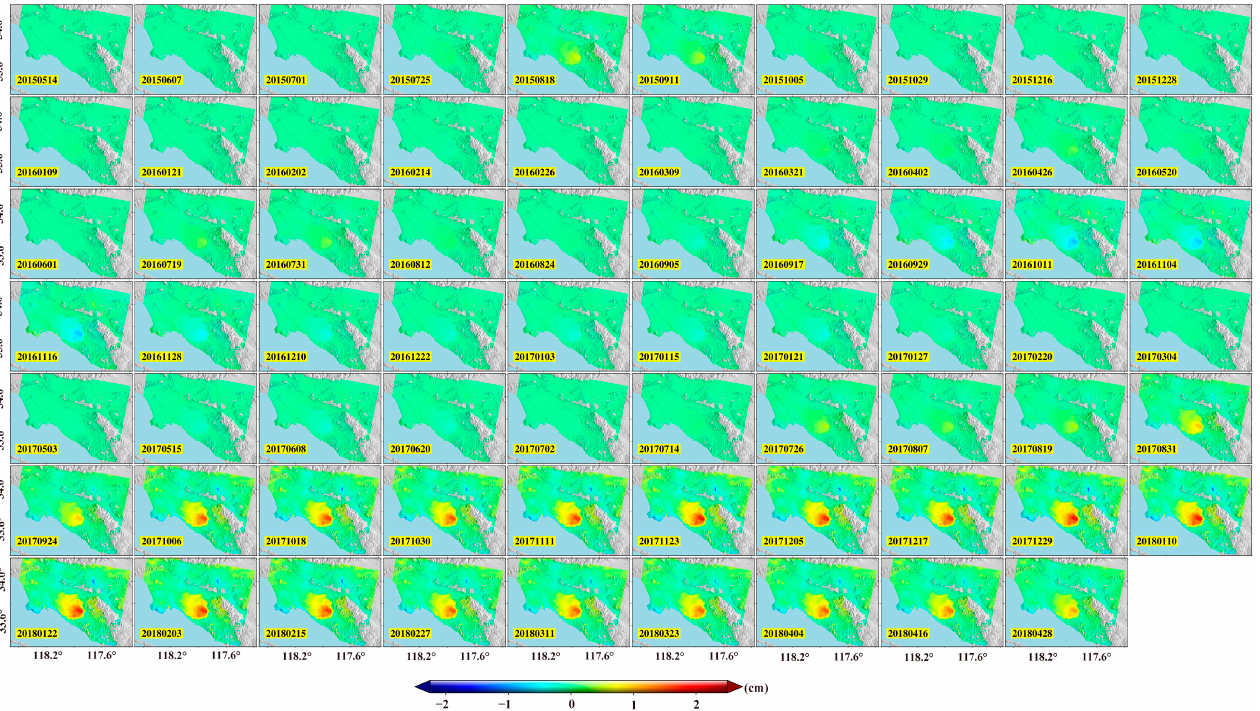
Figure 8. Deformation time series reconstructed from the independent spatial components and temporal eigenvectors for IC1.